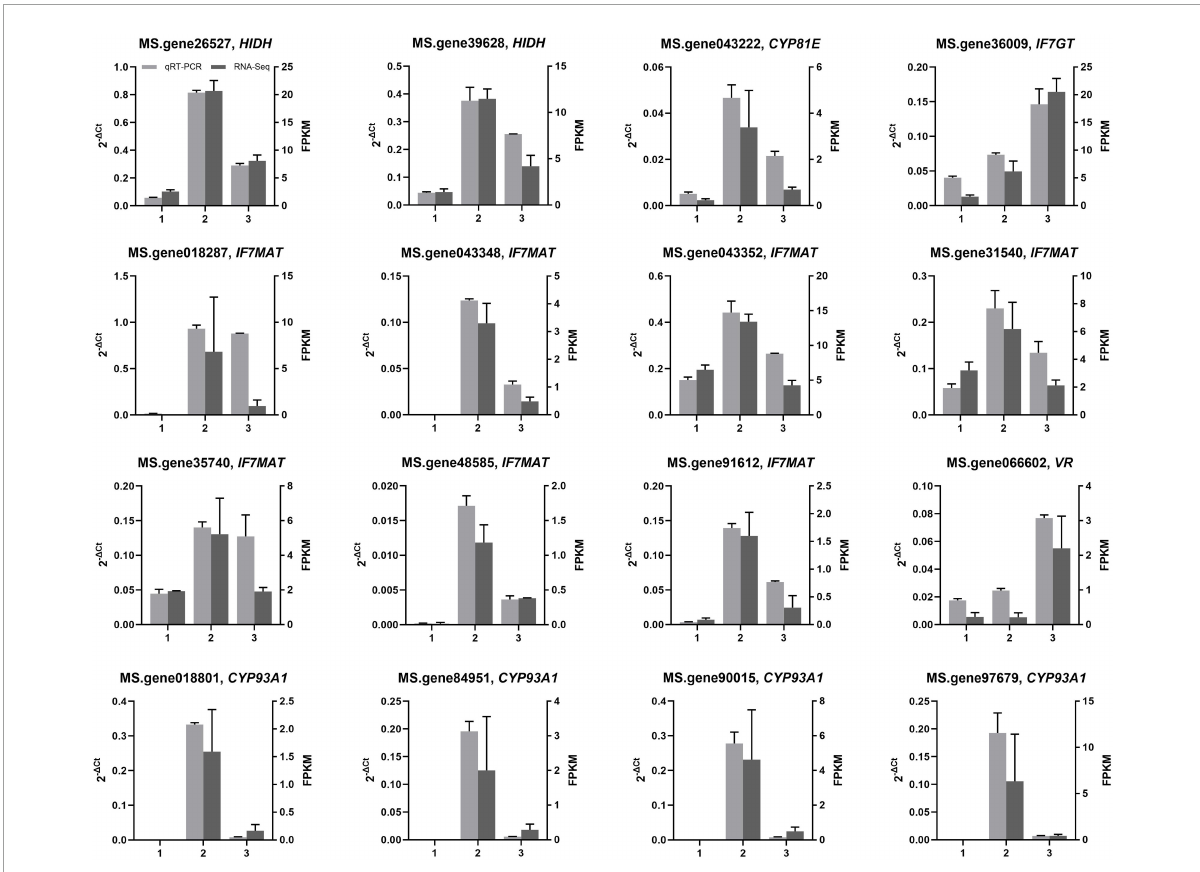
FIGURE6 Analysis of gene expression related to the isoflavonoid biosynthesis pathway. Detection of the relative expression of selected genes in alfalfa seeds (1), green (2), and yellow (3) alfalfa sprouts by RNA-seq and qRT-PCR; values are expressed as means ±